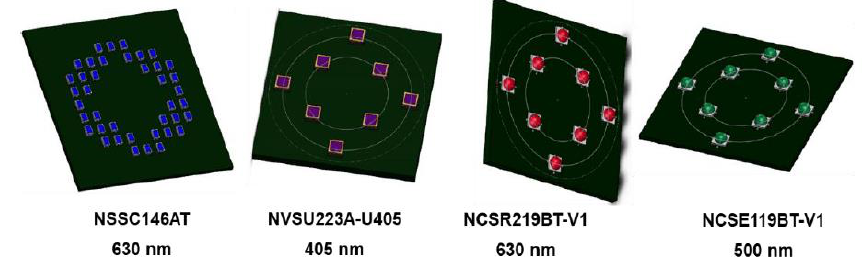
Figure 4. Typologies of boards including different wavelength